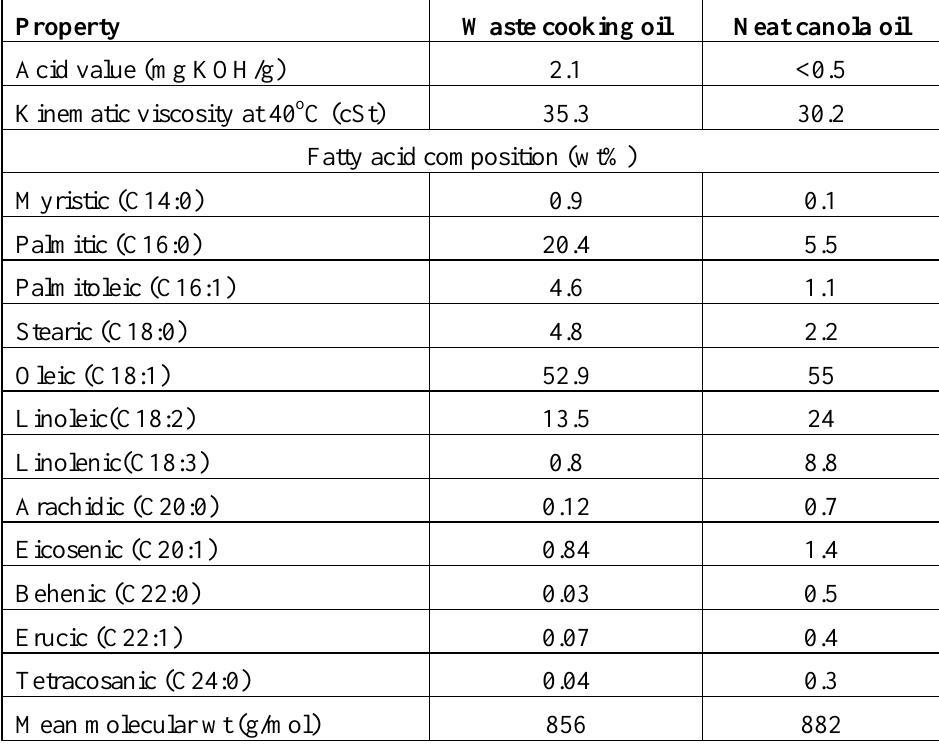
Table 1. Physical and chemical properties of oil feedstocks